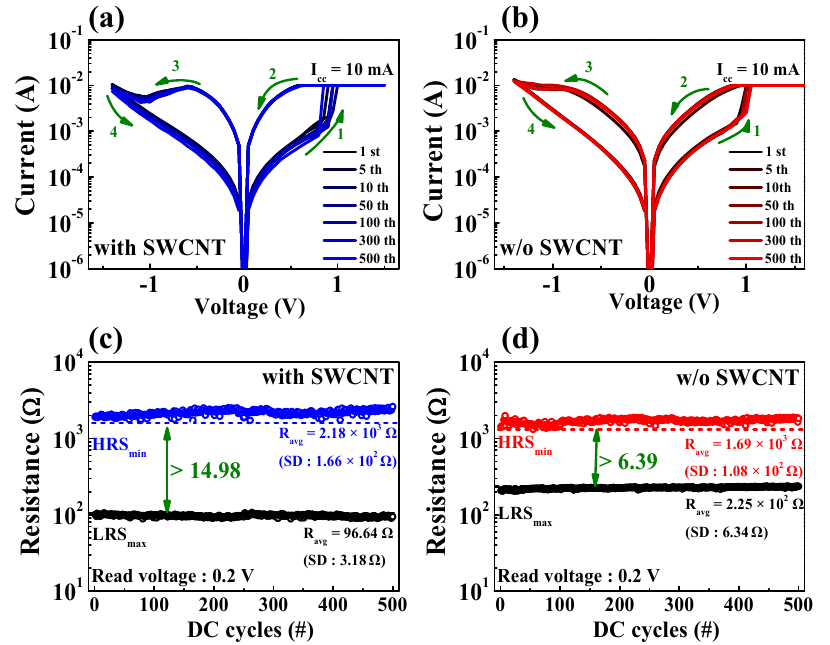
Figure 4. Results of resistive switching endurance tests over 500 DC cycles. BRS I - V curves of chitosan nanocomposite memristors ( a ) with and ( b ) without SWCNT random networks. Resistance states of the chitosan nanocomposite memristors ( c ) with and ( d ) without SWCNT random networks.